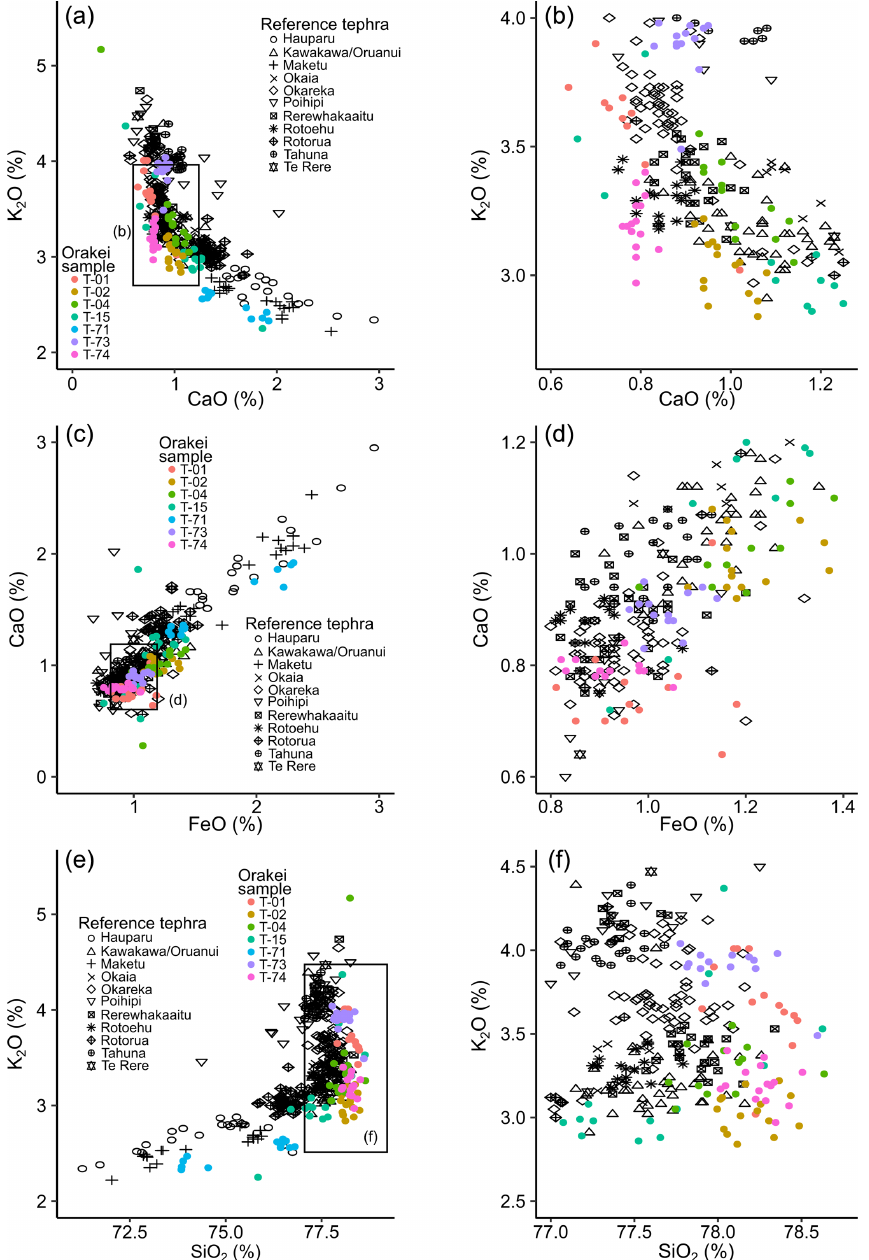
Figure A1. Major element oxide bivariate plots of reference tephra data (black) and Orakei samples (colourful points). Marked insets are enlarged on the right-hand